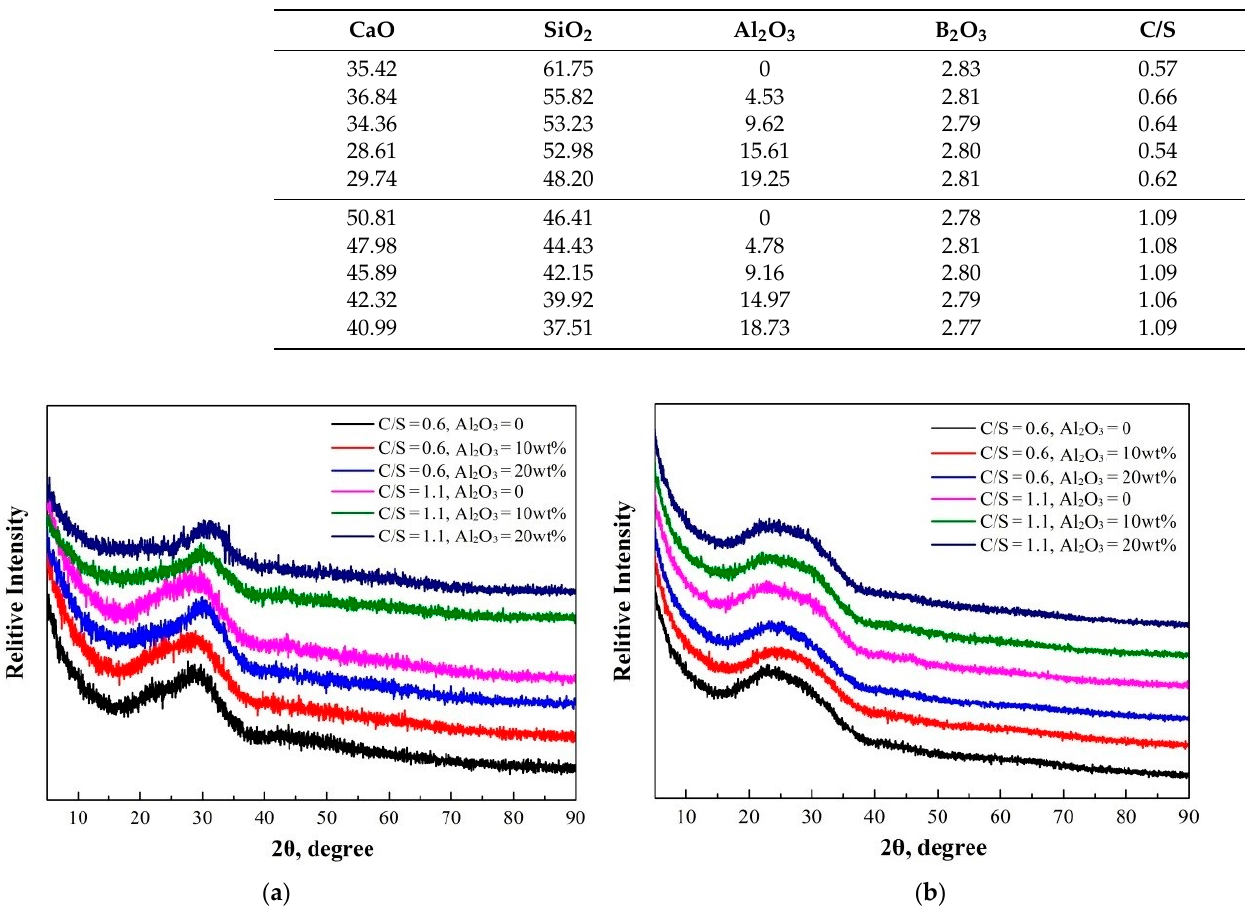
Figure 1. X-ray diffraction results of CaO–SiO 2 –Al 2 O 3 slags: ( a ) 0 B 2 O 3 and ( b ) 3 wt% B 2 O 3.